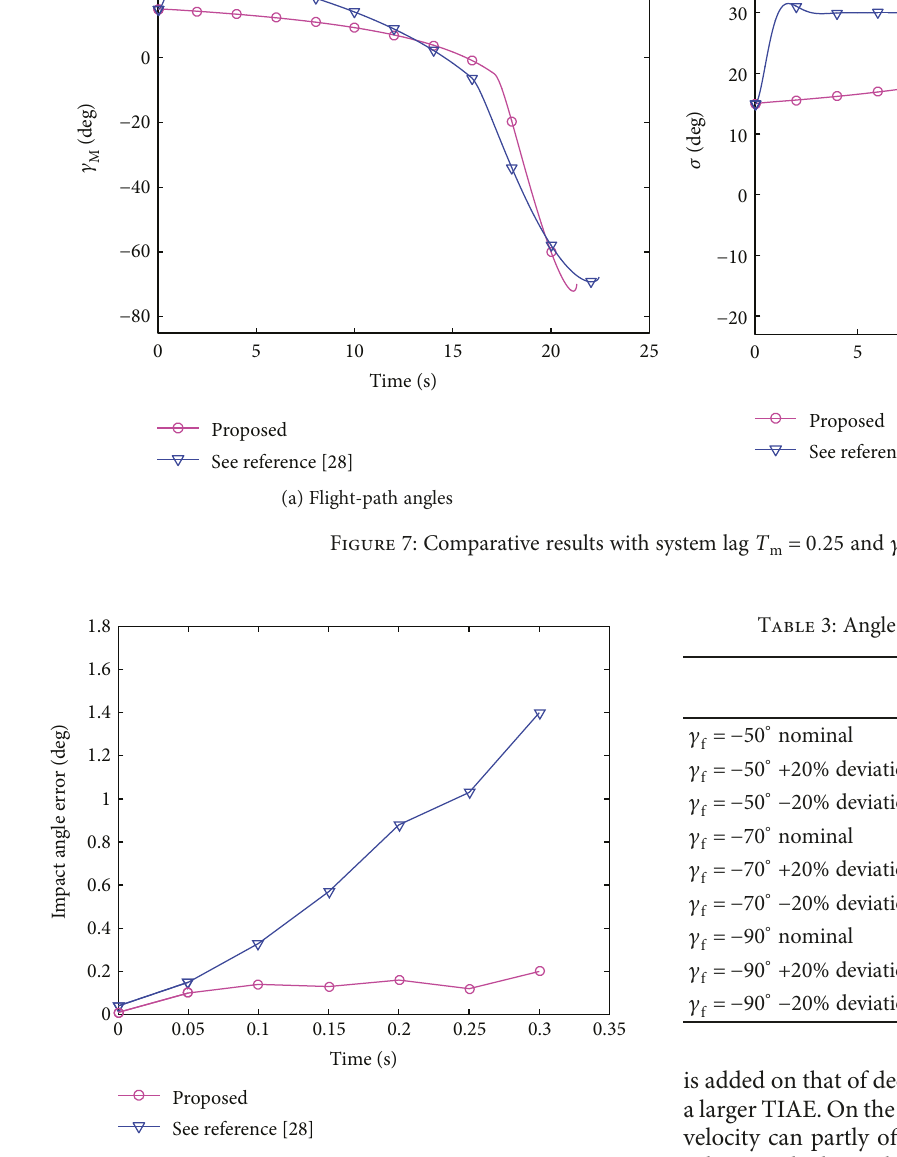
Figure 8: Impact angle error with the variation of system lag.